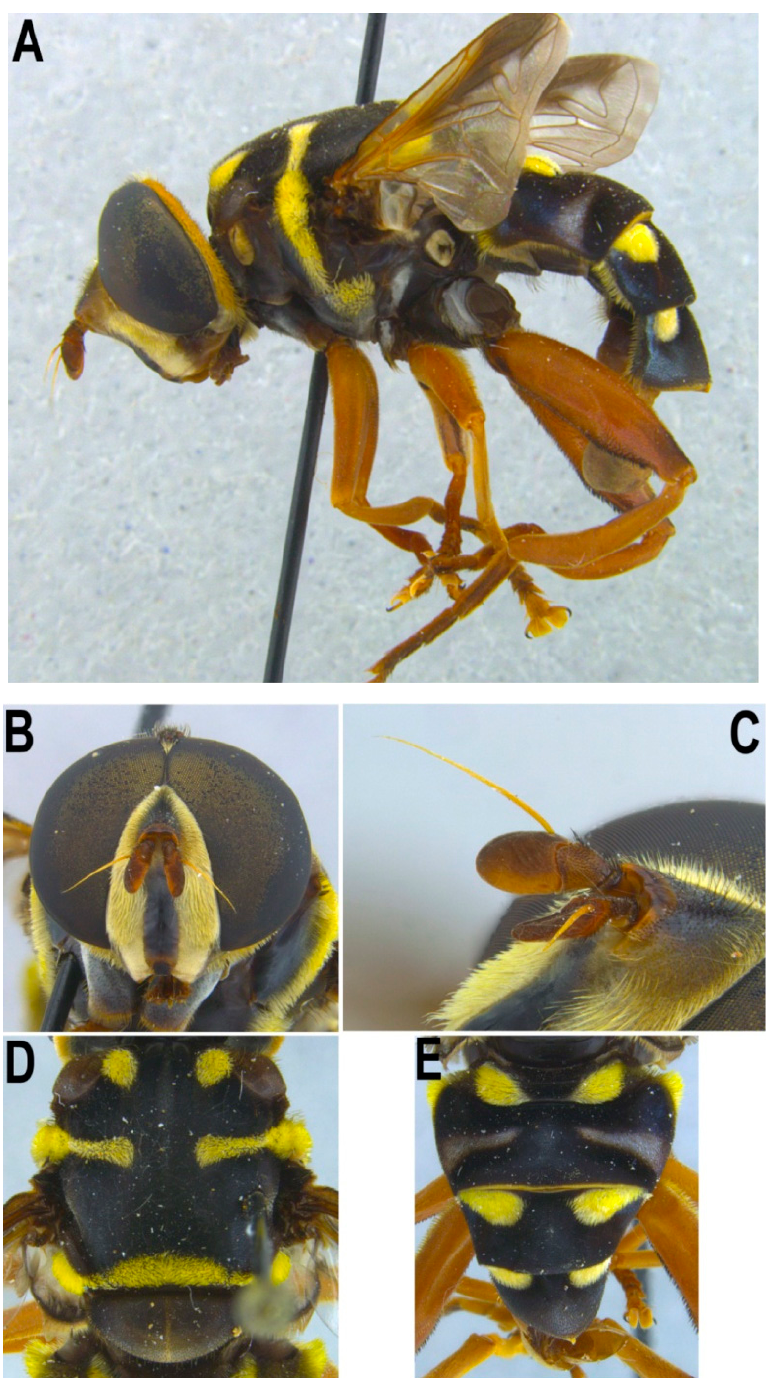
Figure 7. Meromacrus yucatense sp. nov., adult, male holotype. ( A ): entire body, lateral view. ( B ): head, anterior view. ( C ): right antenna, lateral view of inner side. ( D ): thorax, dorsal view. ( E ): abdomen, dorsal-lateral view.